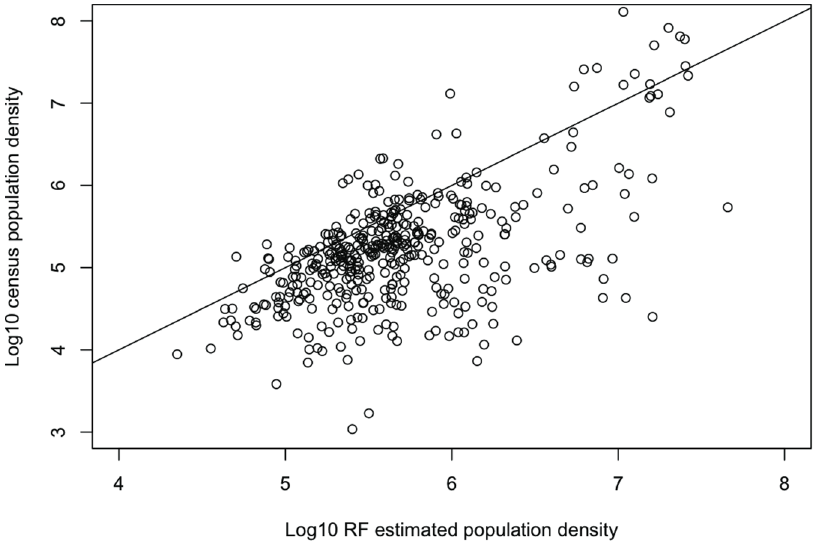
Figure 4. Census population density vs. Random Forest estimated density. 1:1 line plotted for reference.